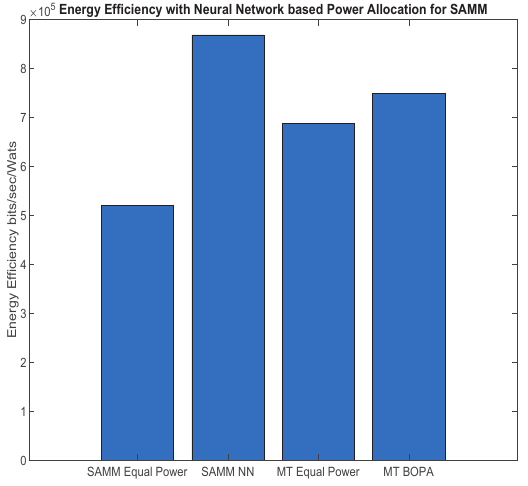
Figure 20. The system energy efficiency with neural network for SAMM which is trained on waterfilling based power allocation among users and BOPA based power allocation among subchannels in a single relay scenario.